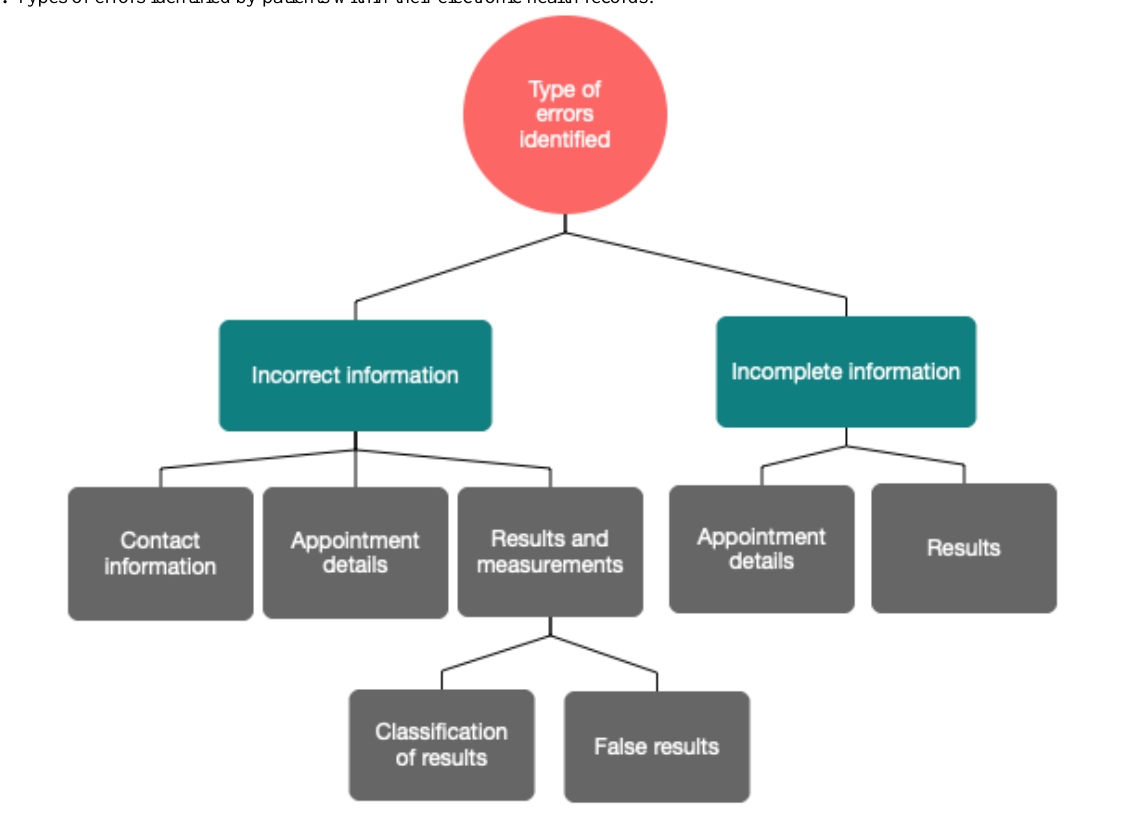
Figure 2. Types of errors identified by patients within their electronic health records.